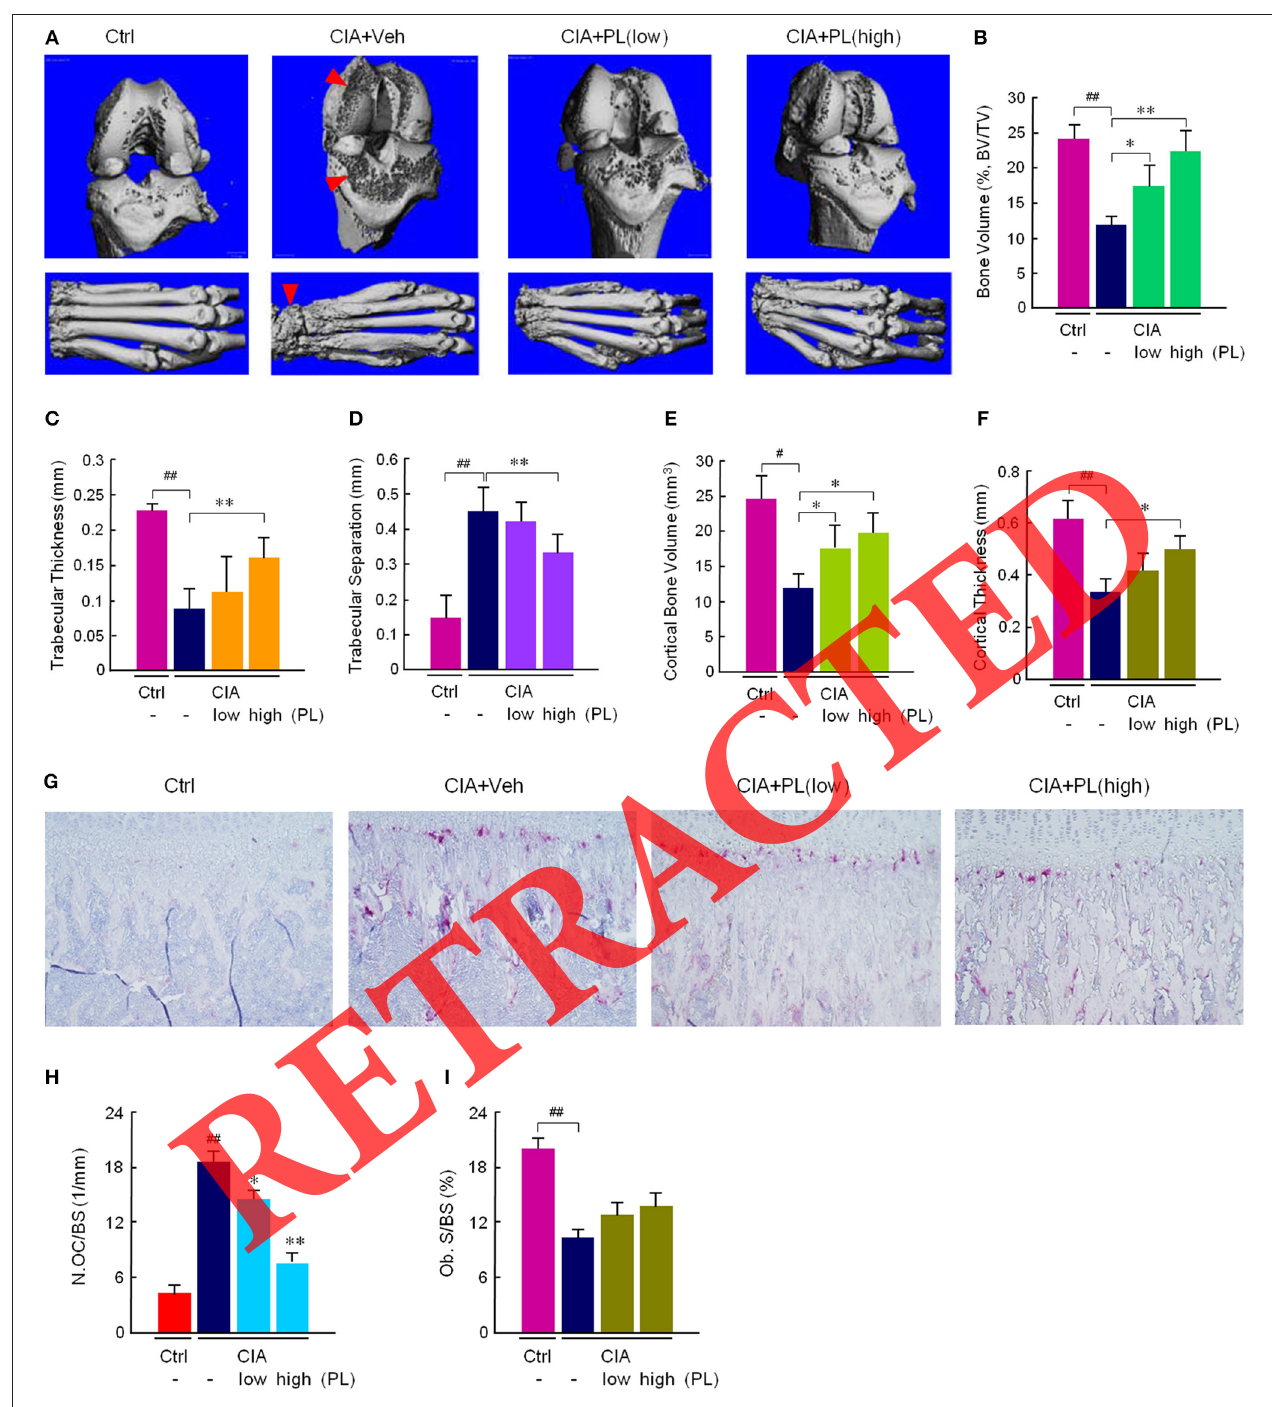
FIGURE 4 | Plumbagin suppresses joint bone erosion and tibial bone loss in rats with CIA. (A) Representative reconstructed 3D micro-CT images of knee and hind paw joints of Ctrl, CIA + Veh, CIA + PL(low), and CIA + PL(high) rats to show joint bone erosion. Red arrowheads indicate sites of joint bone erosion. (B–F) Micro-CT parameters of trabecular bone mass and cortical bone mass are shown in (B) , trabecular bone volume (BV/TV), (C) trabecular thickness, (D) trabecular separation, (E) corticol bone volume, (F) corticol thinkness. (G) Representative histological images of tartrate-resistant acid phosphatase (TRAP) staining for osteoclasts (red) at a region distant to the site of inflammation in the proximal tibia of rats from different groups. Histomophometric quantification of (H) osteoclast number/bone surface (N.Oc/BS), and (I) osteoblast surface/bone surface (Ob.S/BS) in rats from different groups. Quantitative results are presented as mean ± SEM, and n = 5/group. # P < 0.05, ## P < 0.01 vs. normal control rats. * P < 0.05; ** P < 0.01 vs. vehicle-treated CIA